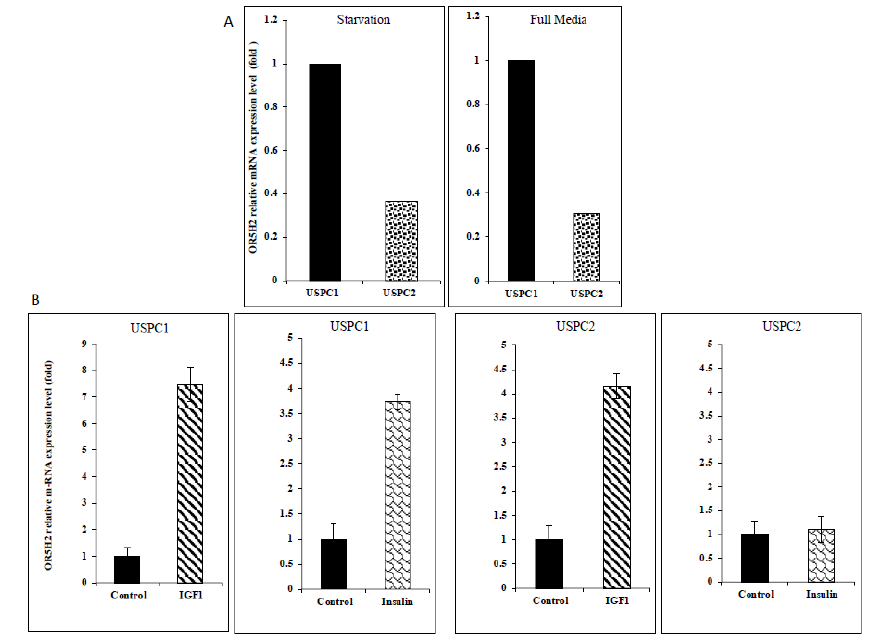
Figure 2. Effect of IGF1 and insulin on OR5H2 mRNA levels in USPC1 and USPC2 endometrial cancer cell lines. ( A ) USPC1 and USPC2 cells were kept in serum-free (starvation) or serum-containing (full) media for 24 h, after which total RNA was extracted and steady-state OR5H2 mRNA levels were measured by qPCR. ( B ) USPC1 and USPC2 cells were serum-starved for 24 h, after which they were treated with IGF1 or insulin (50 ng/mL) for 24 h. At the end of the incubation period, cells were harvested and the OR5H2 and GAPDH mRNA levels were quantitated by qPCR. A value of 1 was given to the normalized value in control cells. Bars are mean ± SEM of three independent experiments, each performed in triplicate. To assess the effect of IGF1 and insulin on OR5H2 expression, the USPC1 and USPC2 cells were grown in a serum-free medium for 24 h and then treated with IGF1 or insulin (50 ng/mL) for an additional 24 h. The relative OR5H2 mRNA expression was evaluated by qPCR and normalized to the internal control GAPDH mRNA. IGF1 enhanced the OR5H2 mRNA levels in the USPC1 and USPC2 cells by 7.3- and 4.2-fold, respectively. Insulin stimulated expression only in the USPC1 cell line (3.7-fold increase) (Figure 2B). To establish whether the mRNA changes were associated with corresponding changes at the protein level, OR5H2 was measured by Western blots. Both hormones stimulated the OR5H2 protein levels in both cell lines, although the effect of insulin in the USPC1 cells was very small (Figure 3). Taken together, the effect of IGF1 on the OR5H2 mRNA and protein levels was stronger than that of insulin in both cell lines. Data confirm that the OR5H2 gene is a downstream target for IGF1/insulin stimulatory activity.